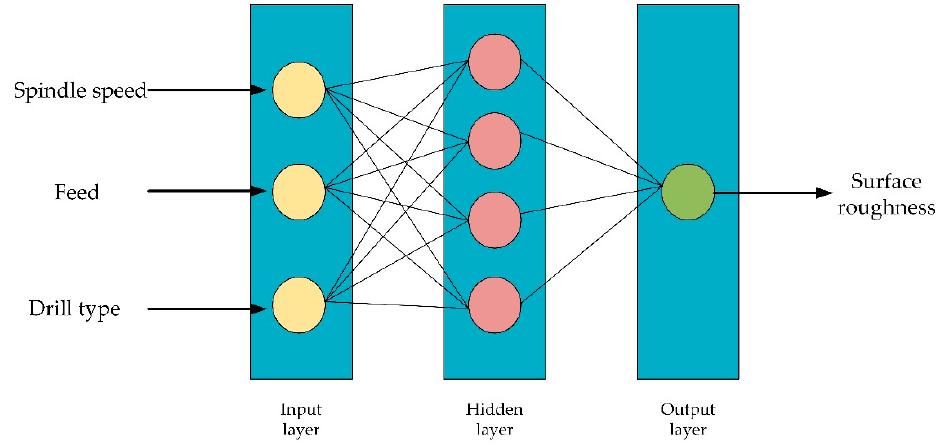
Figure 8. The architecture of the artificial neural network.